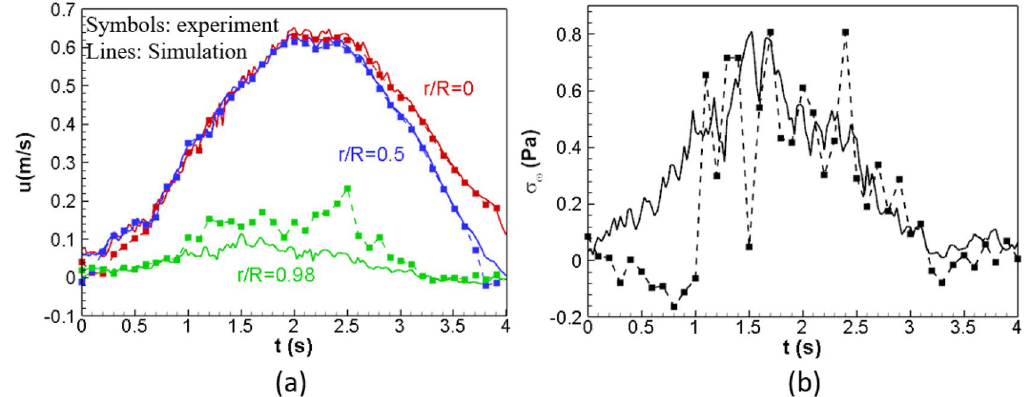
0 ), middle location ( r / R Figure 8. Comparisons of (a) velocity waves at the center ( r / R = 0.98 ) and (b) WSS wave between numerical simulation (lines) and experimental near boundary ( r / R = 4735 and α measurement (symbols) with Re 0 = =